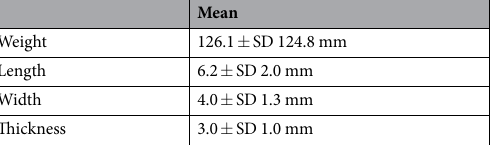
Table 1. Averages of the DSTs measurements. Tools used by both groups, N = 703.